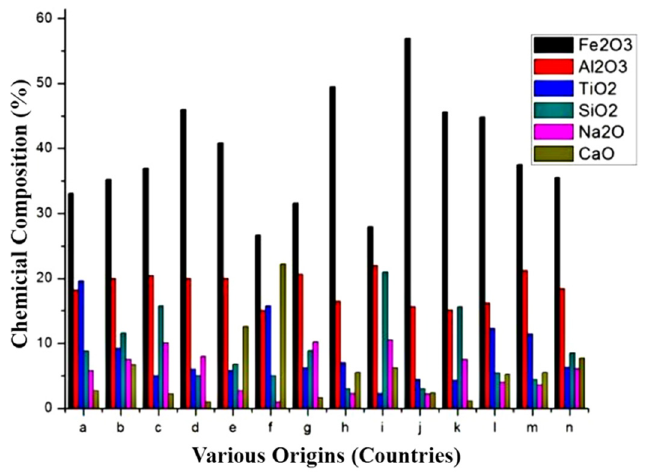
Figure 4. Chemical composition of red mud from various origins [108].